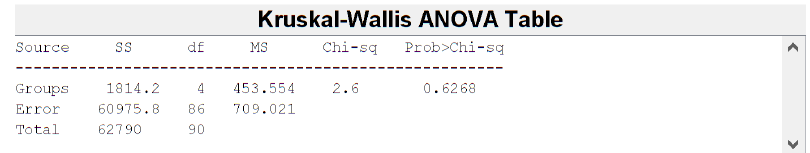
Figure 8. t-SNE results for different distance measurements. ( top left ): Euclidean distance, ( top right ): cityblock distance, ( bottom left ): chebychev distance, ( bottom right ): minkowsi distance.